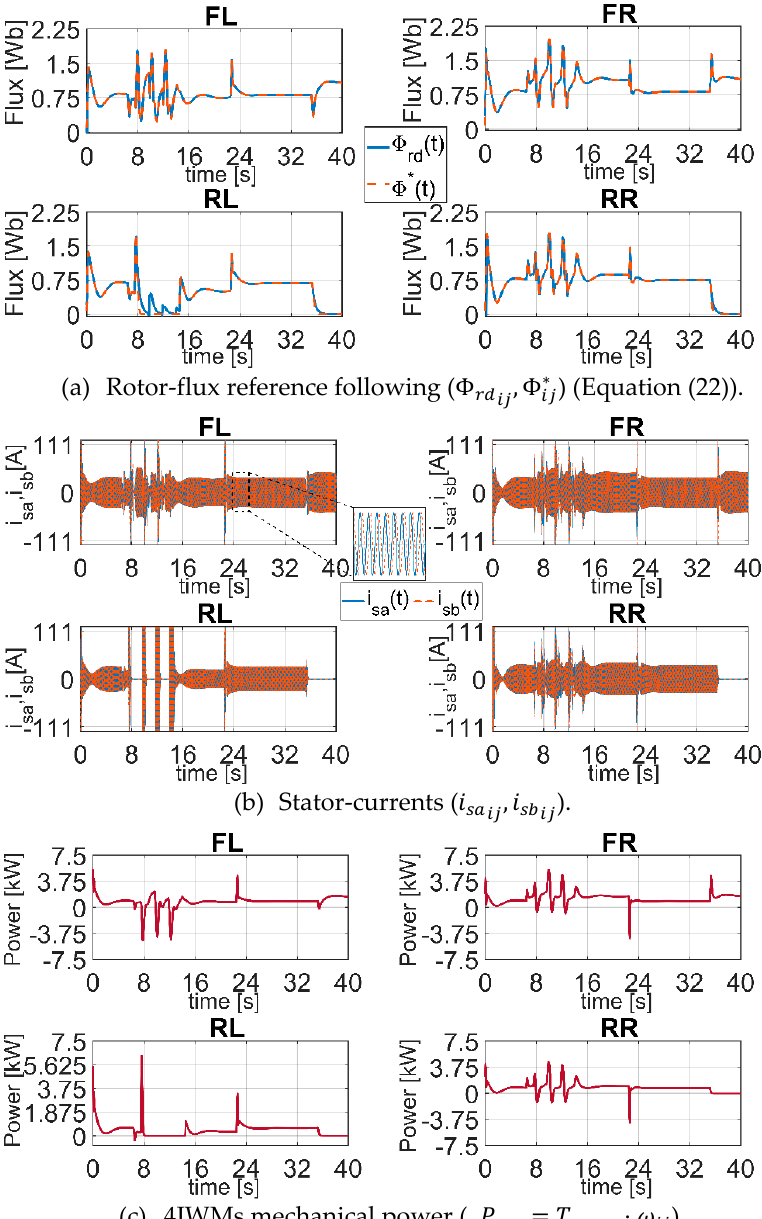
Figure 27. Bending on Low-Friction Patch: 4IWM fluxes, currents and powers (Equations (12) and (13)).